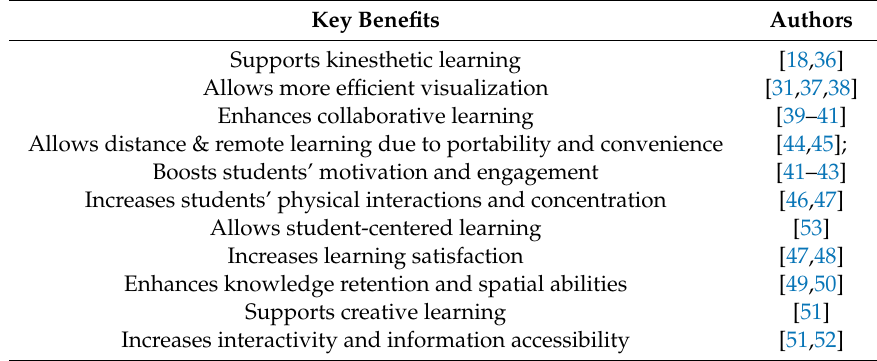
Table 3. Summary of the key benefits of augmented reality (AR) in e-learning